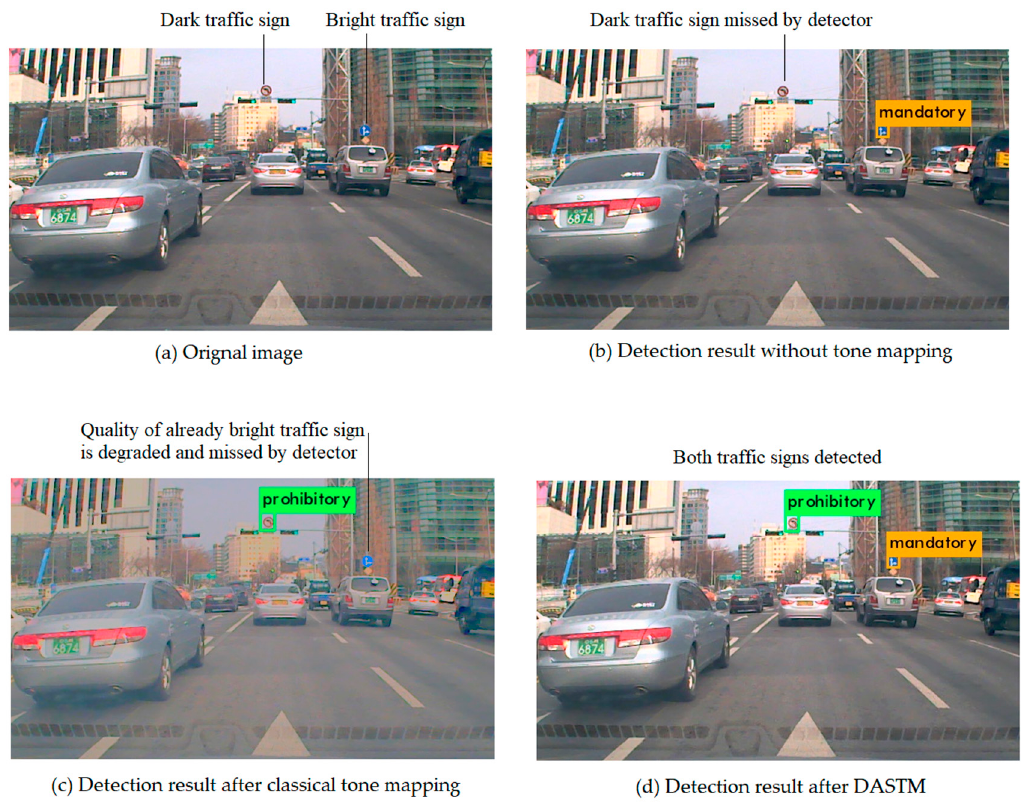
Figure 2. Typical results of detection: ( a ) original image; ( b ) detection without tone mapping, in which a dark traffic sign is missed; ( c ) detection after classical tone mapping, in which a bright traffic sign is missed; and ( d ) detection after DASTM, in which both traffic signs are successfully detected.